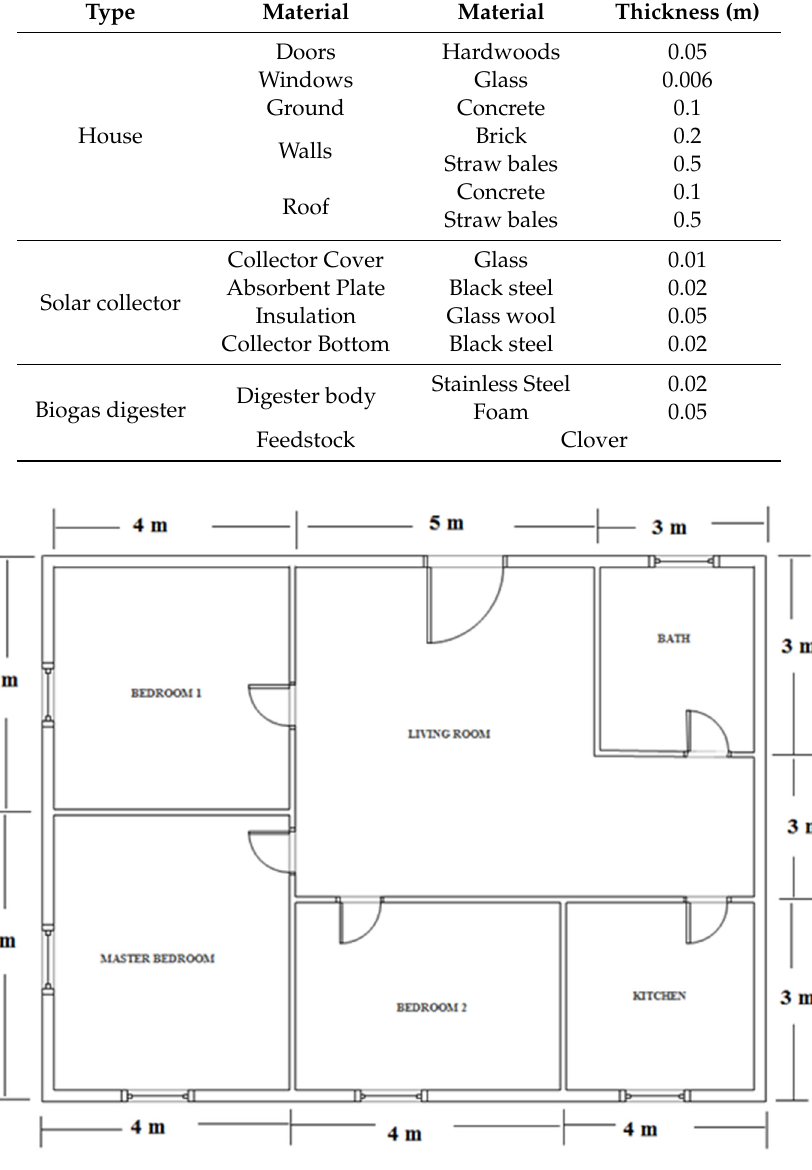
Figure 9. Floor plane of single-family detached house.